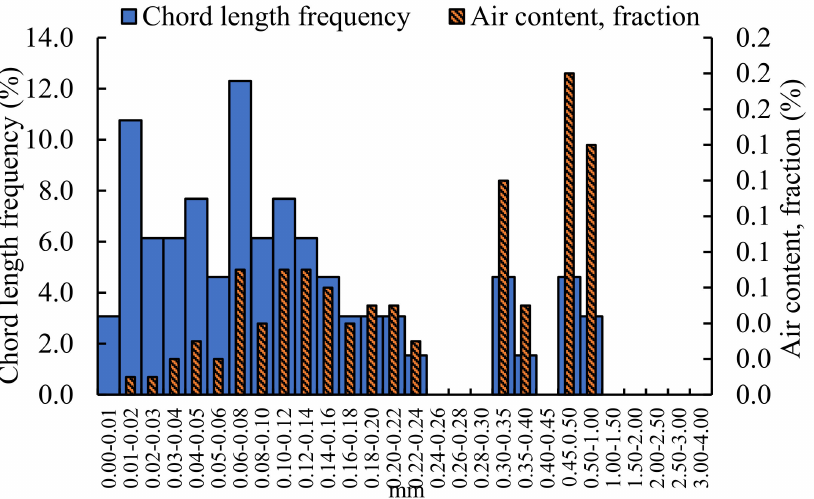
Figure 8. Analysis of pores structure of grouting material mixed with 0.8%